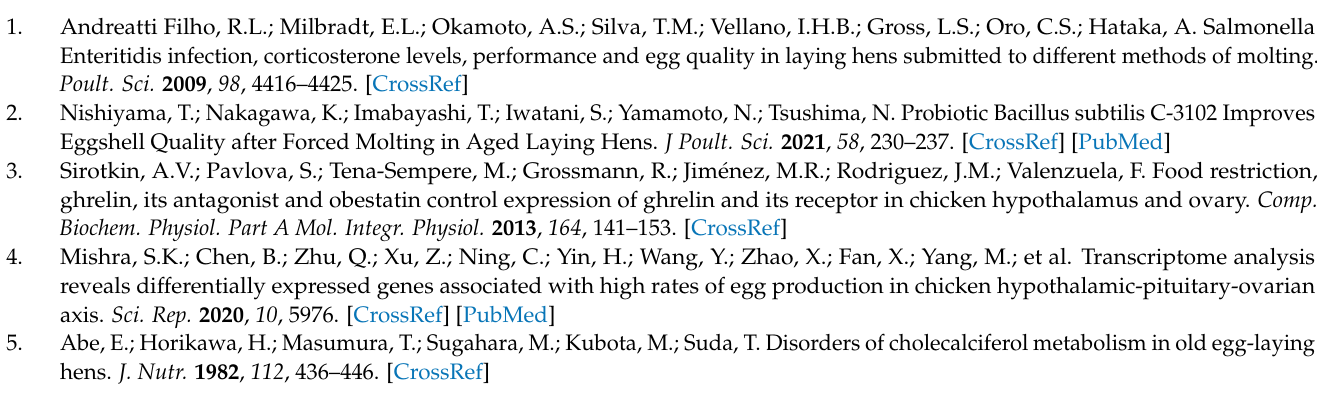
DNA methylation sequencing data, Table S2: The proportion of methylated C sites in CG, CHG and CHH contexts of 30 samples from forced molting, Table S3: The hypo DMRs and their corresponding DMGs in hypothalamus of 1-vs.-2, Table S4: The hypo DMRs and their corresponding DMGs in ovary of 1-vs.-2, Table S5: The hypo DMRs and their corresponding DMGs in hypothalamus of 2-vs.-3, Table S6: The hypo DMRs and their corresponding DMGs in ovary of 2-vs.-3, Table S7: The hypo DMRs and their corresponding DMGs in hypothalamus of 3-vs.-5, Table S8: The hypo DMRs and their corresponding DMGs in ovary of 3-vs.-5. Table S9 The DMGs associated with cellular aging in three different periods. Figure S1: The CpG region correlation of samples for 1-vs.-2 group in hypothalamus, Figure S2: The CpG region correlation of samples for 1-vs.-2 group in ovary, Figure S3: The CpG region correlation of samples for 2-vs.-3 group in hypothalamus, Figure S4: The CpG region correlation of samples for 2-vs.-3 group in ovary, Figure S5: The CpG region correlation of samples for 3-vs.-5 group in hypothalamus, Figure S6: The CpG region correlation of samples for 3-vs.-5 group in